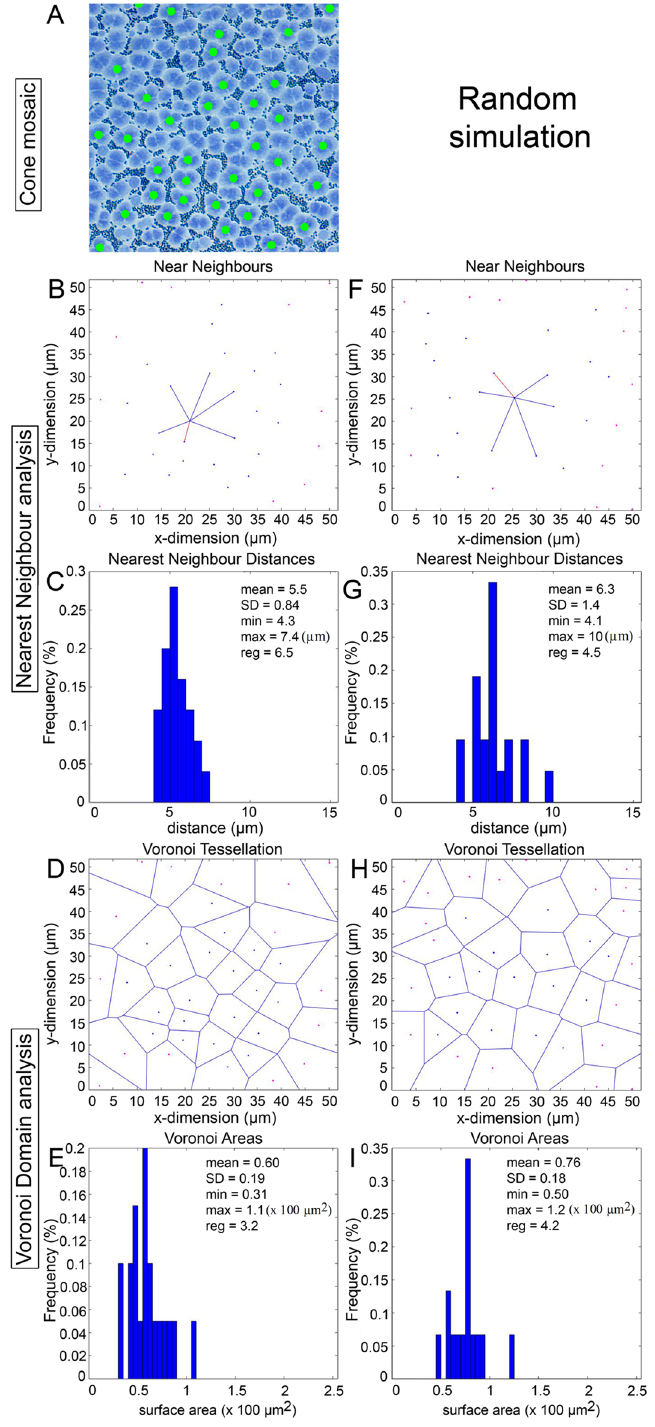
Figure 11. Spatial analysis of triple cone distributions ( A ) from the same mosaic shown in ( K ) of Fig. 9. Triple cones are marked with green dots. ( F – I ) Same presentation of data as per ( B – E ) but for a random distribution of points matched for density with that in ( A ) and constrained by triple cone soma size. Presentation of data as in Fig.